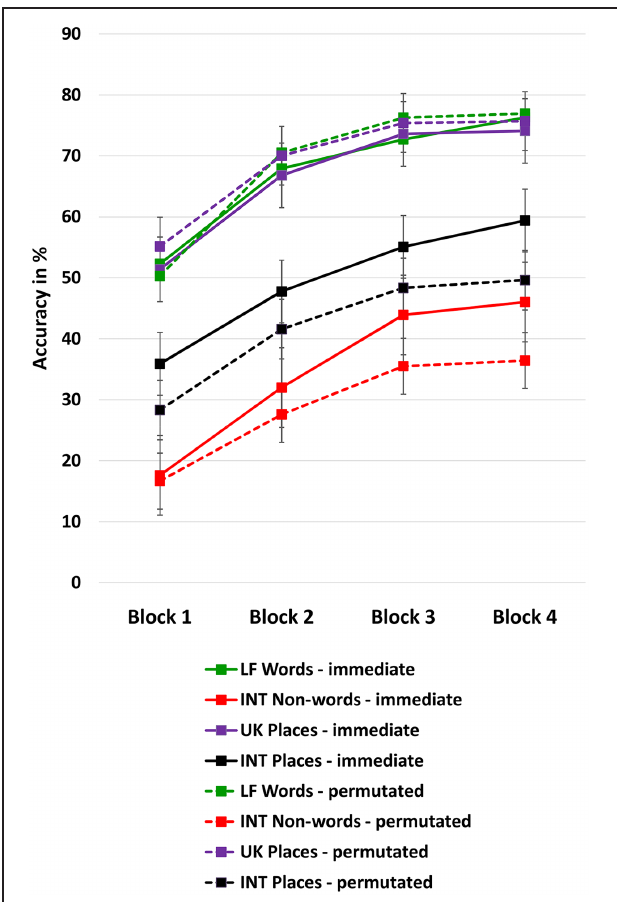
FIGURE 2 | Effects of content. Memory for geographic place names was better than for LF words and non-words. This difference was somewhat less pronounced for completely correctly spelled words (pastel colored lines). It stayed significant throughout the experiment, but increasingly higher correlations between places and words indicated that content became less important during the experiment. Means are controlled for age. Bars denote the